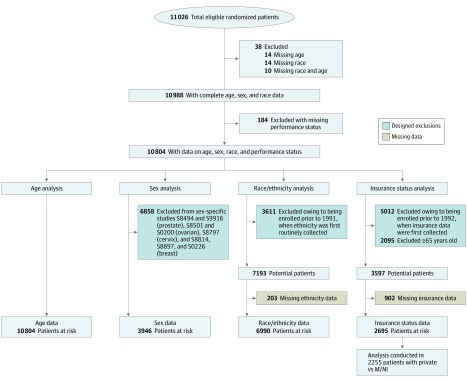
Study Population for Each Sociodemographic Variable AnalysisM/NI represents Medicaid or no insurance.